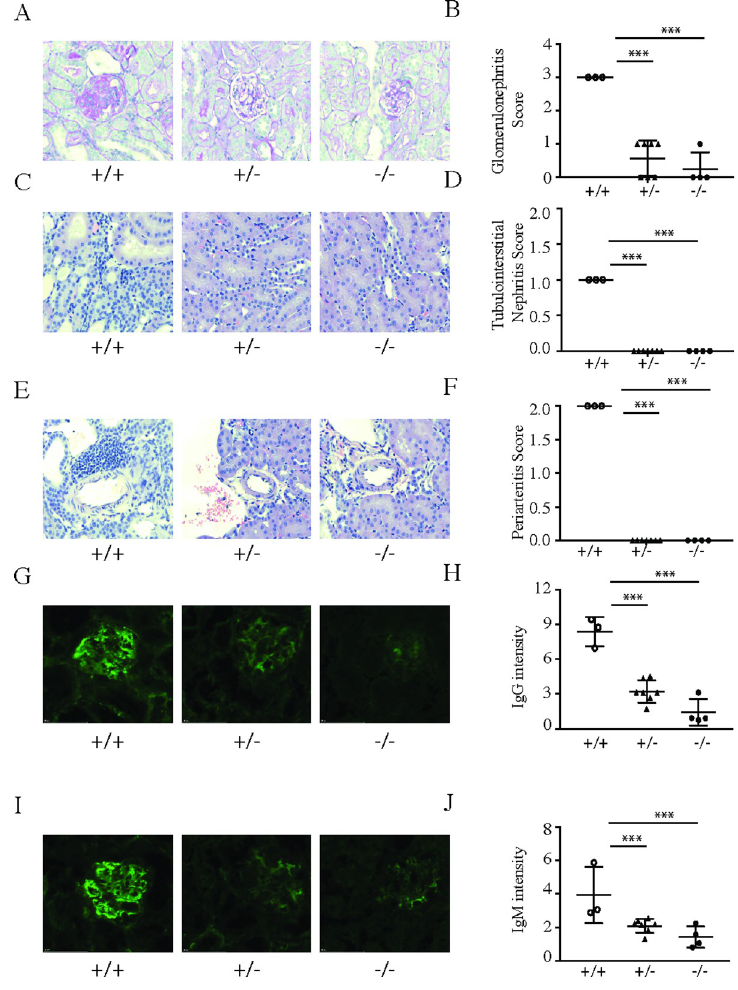
Fig 5. Lack of SLC15A4 protects mice from developing spontaneous lupus nephritis in NZB/W F1 mice. NZB/W F1 slc15a4 +/+ , slc15a4 +/- , and slc15a4 -/- mice were euthanized at the age of 36 weeks. H&E and PAS staining was carried out on formalin fixed tissues to assess renal disease severity by comparing severity scores of glomerulonephritis (A, B), tubulointerstitial nephritis (C, D) and periarteritis (E, F). Immune-complex deposition in kidney was assessed in frozen tissue sections by staining for IgG (G,H) and IgM (I,J) and quantified using FITC/AF488 integrated intensity in renal cortex. Examples (A, C, E, G, I) and quantification over several samples (B, D, F, H, J) is shown. Data is plotted with group means ± SD; individual data points represent results from two kidney sections on one slide from an individual mouse. � p < 0.05, �� p < 0.005, ��� p <